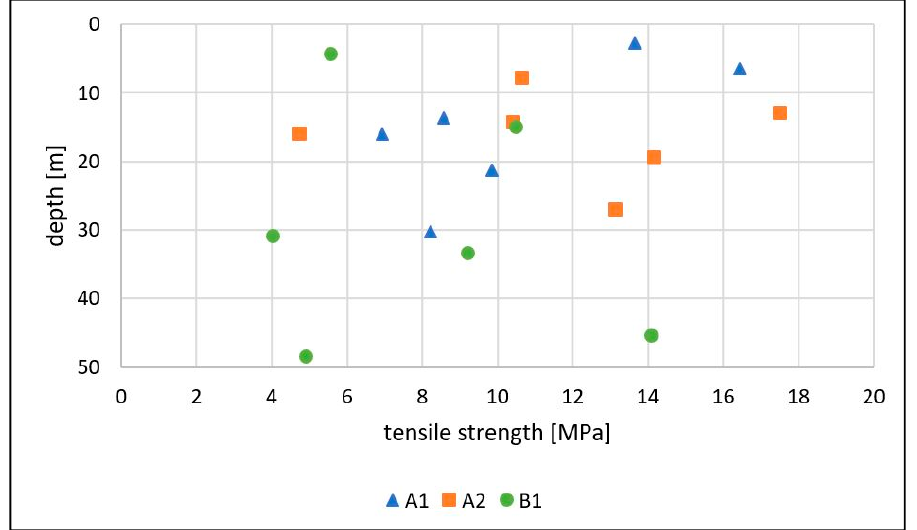
Figure 9. Results of the tensile strength tests (Brazilian tests) plotted vs. the depth of the sampling.